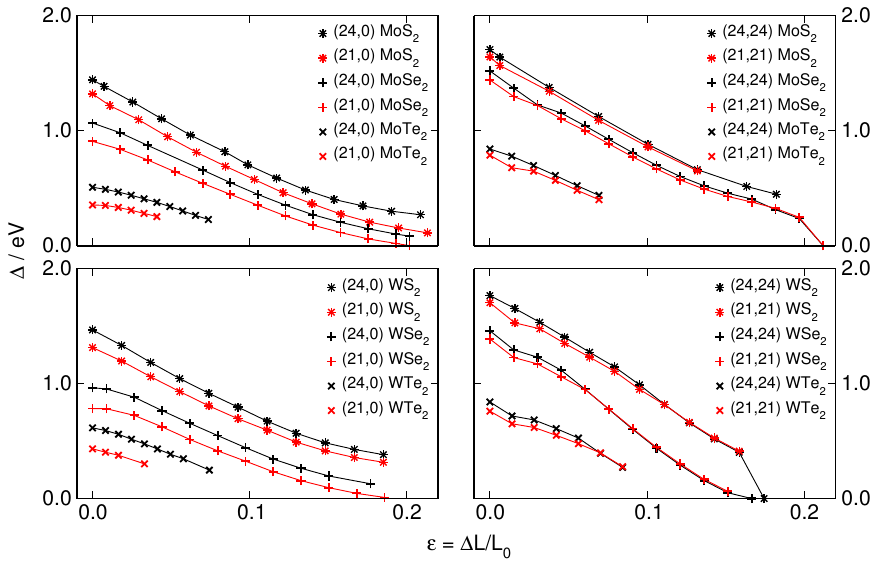
Figure 6. The calculated band gap evolution with the applied tensile strain of zigzag and armchair TX 2